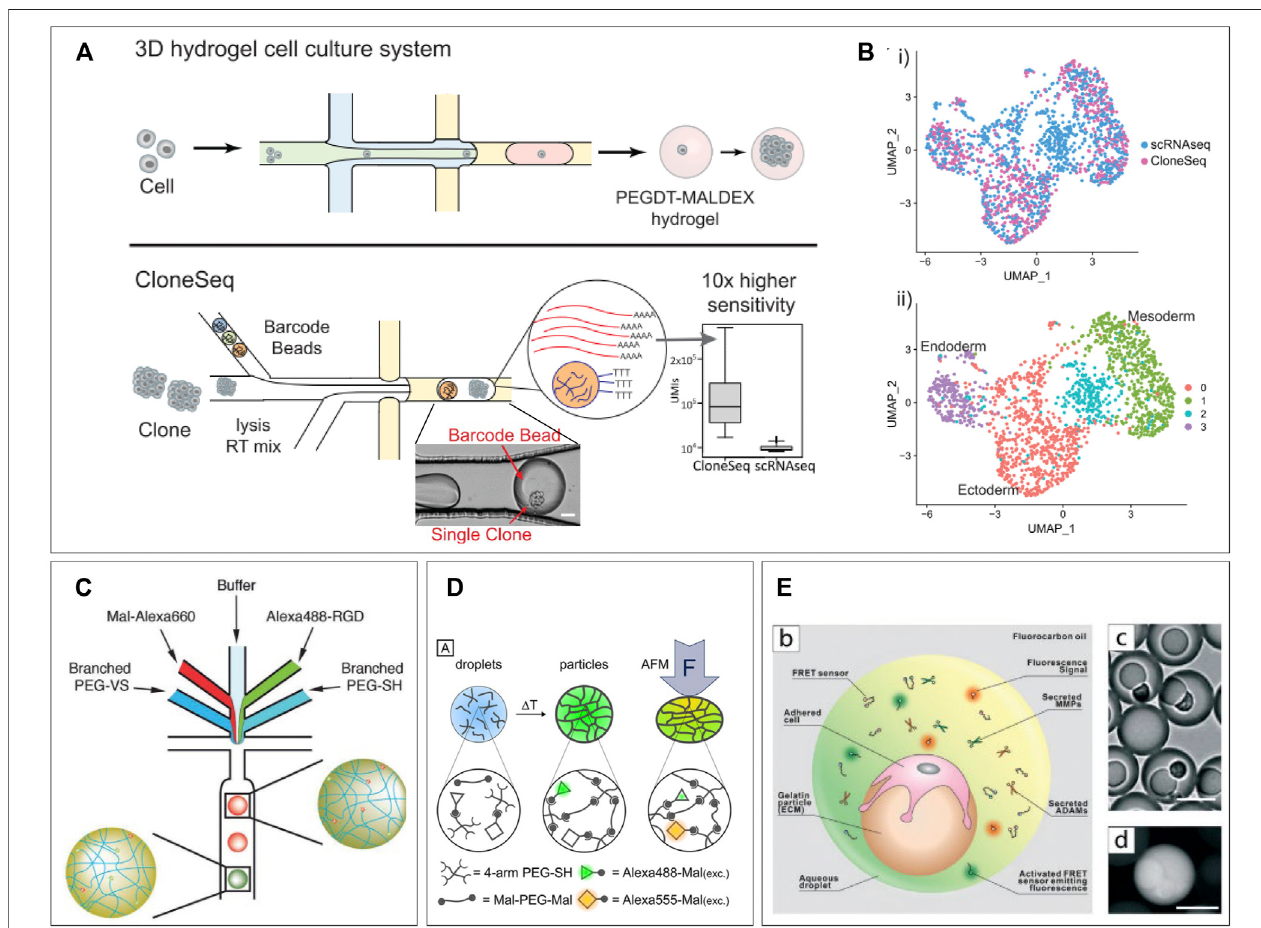
FIGURE 3 | Single-cell applications. (A) CloneSeq platform: single-cells are encapsulated in a hydrogel droplet and cultured to form a population of clones. This population is sequenced using an adapted sequencing protocol. (B) CloneSeq protocol exhibits improved separation of different stem cell differentiation states compared to conventional single-cell RNA sequencing (Bavli et al., 2021). (C) Micro fl uidic device for production of a library of droplets with unique mechanical and functionalization properties, which can be detected based on fl uorescent signature. Adjusting the ratios of branched PEGs and the fl uorophore channels allows tuning of droplet properties during production (Allazetta et al., 2017). (D) PEG-based hydrogel droplets incorporated with FRET pairs display fl uorescence as a result of deformation, creating the potential to measure cell-exerted forces in-droplet (Neubauer et al., 2019). (E) Hydrogel droplets with attached cells are re-encapsulated in droplets along with FRET sensors which become fl uorescent when bound by various proteases. This platform allows the single-cell measurement of proteases on different types of tumor cells to probe their metastatic behavior (Wang et al., 2021).